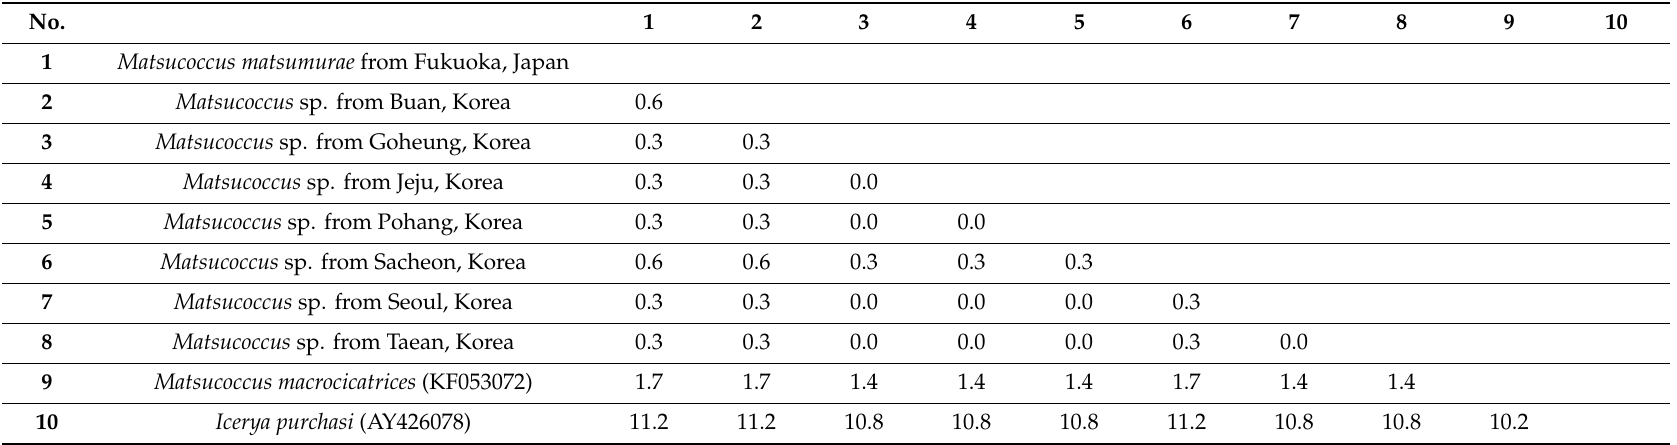
Table 3. Genetic distances (%) of 18S sequences estimated by Neighbor-joining with Kimura-2 parameter model. No.